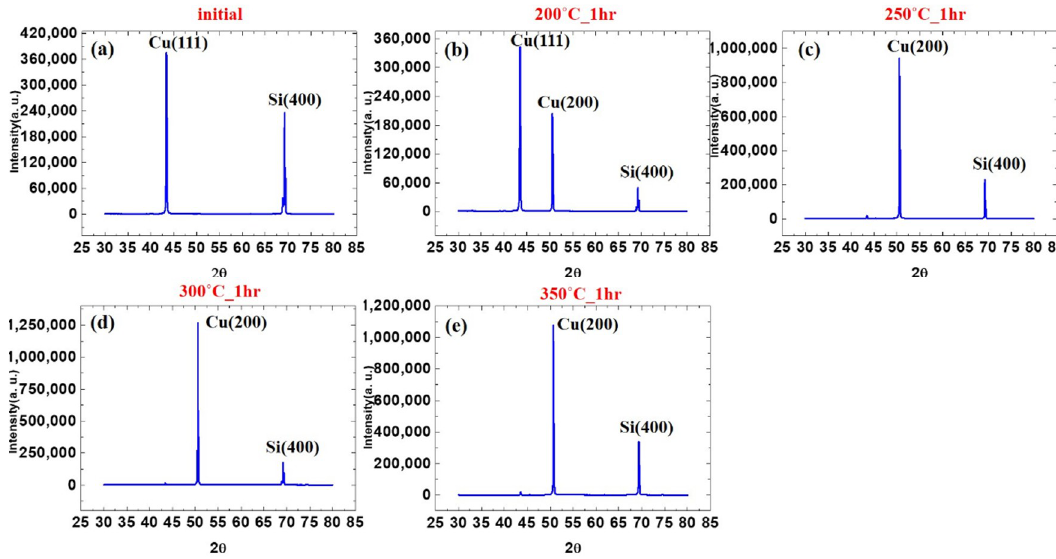
Figure 2. X-ray diffraction intensities of the samples at ( a ) Initial state and annealed at ( b ) 200 °C. ( c ) 250 °C. ( d ) 300 °C. ( e ) 350 °C for an hour.